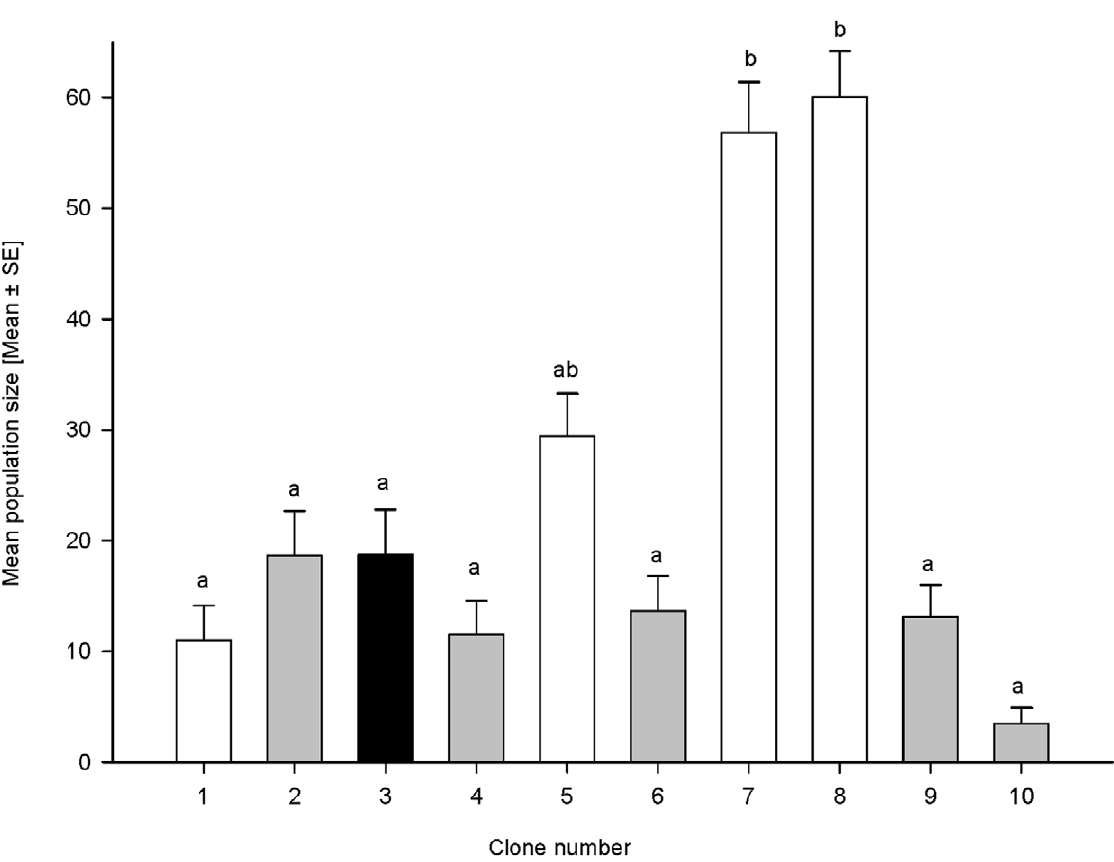
Figure 1. Population (Mean ± SE) of Sitobionavenae on 10 cocksfoot cultivars. White bars: clones collected from wheat; black bar: clone collected from Bromus sp .; grey bars: clones collected from Dactylis glomerata .